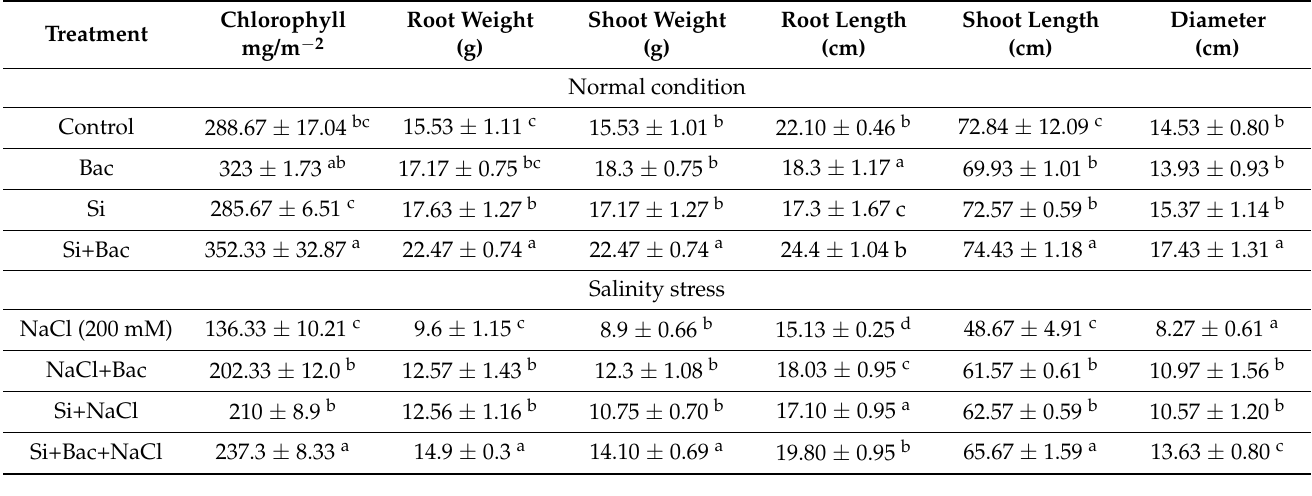
Table 1. The effect of isolate CS51, Si, and co-application of isolate CS51 + Si on the growth, biomass, and chlorophyll content of maize plants under normal and NaCl stress (200 mM). Each value represents the mean ± SD of three replicates. Values in a column followed by different letters are significantly different as evaluated by Duncan’s Multiple Range Test (DMRT).